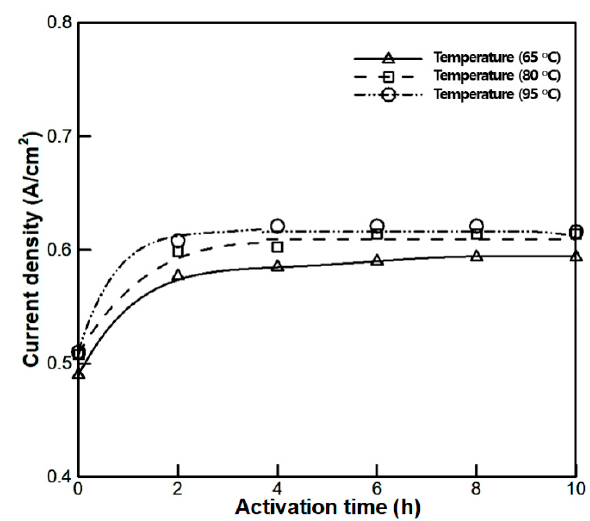
Figure 7. Conditioning of PEM fuel cell depending on operating temperature.